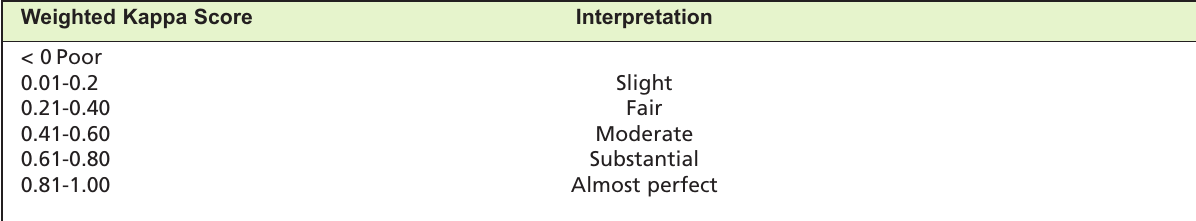
Weighted Kappa Score based on Landis and Koch 13 Table I: